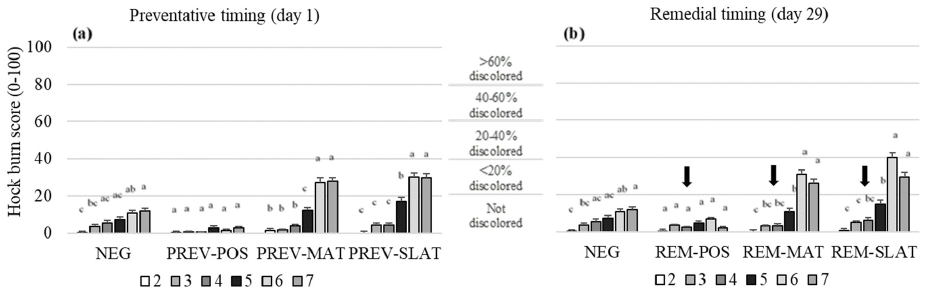
Figure 3. Mean hock dermatitis scores (raw means ± SEM) of birds that received ( a ) preventative provision of the flooring treatments (PREV) ( b ) or birds that received remedial provision of the flooring treatments (REM): negative control (NEG (presented twice)), clean litter (POS), iodine mat (MAT), or iodine mate with slatted floor (SLAT) during weeks 2 through 7 of age. Scores are on a 0–100 tagged analog scale (tVAS), with increasing scores representing a worsened condition (the “tags” on the VAS are indicated by the horizontal gridlines at each 20-point increase). The arrows (b) indicate the timing with different superscripts ( a–c ) differ significantly at p < 0.05.